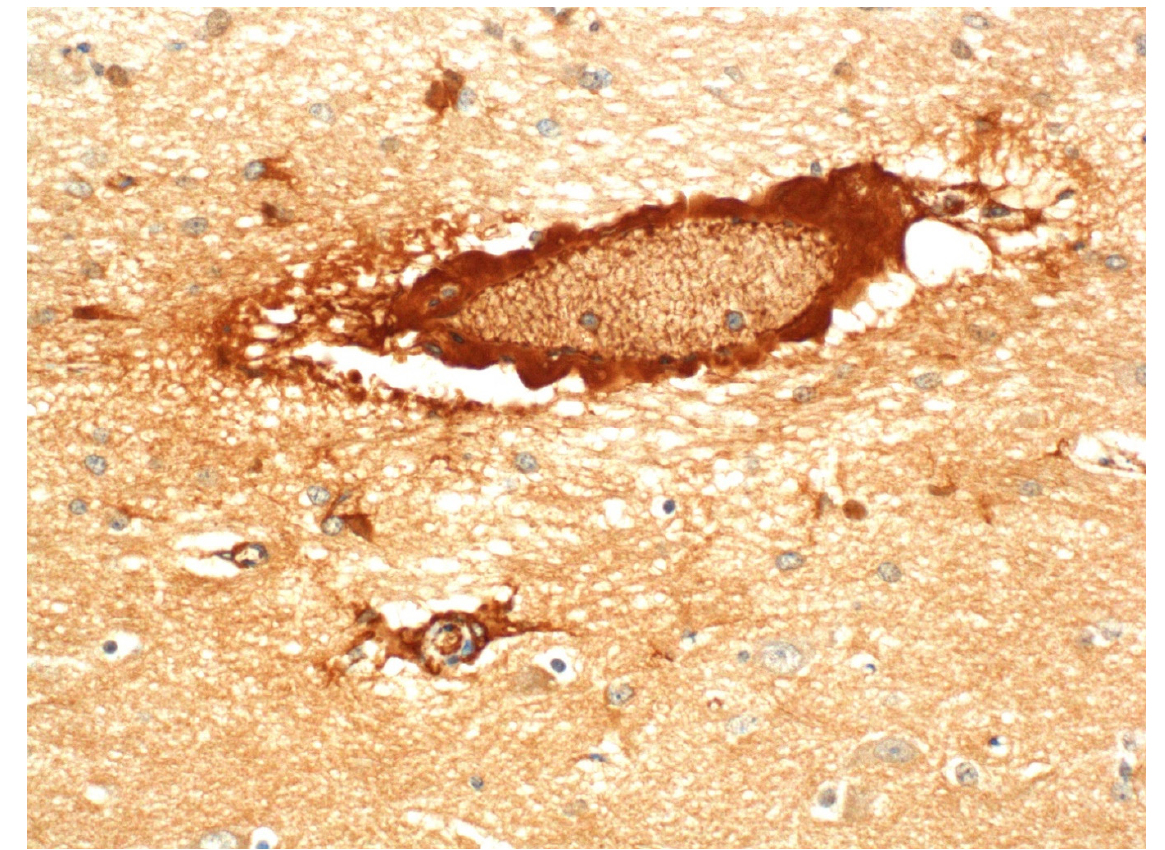
Figure 4. Perivascular accumulation of extravasated plasma albumin as a surrogate marker of increased vascular permeability in acute ovine ETX intoxication. Albumin immunohistochemistry.